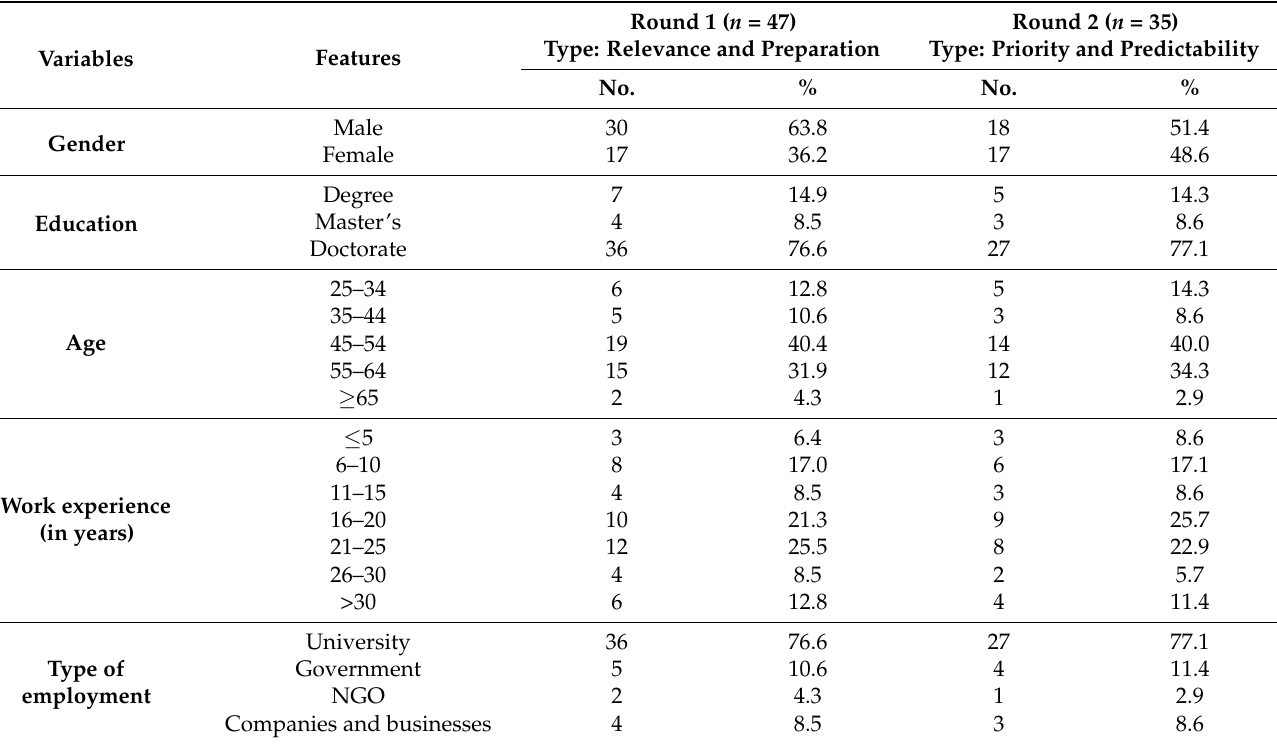
Table 3. Sociodemographic profile of expert